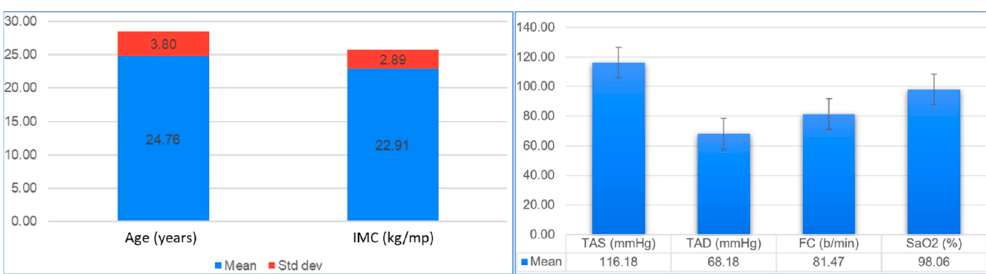
Figure 12. Biological parameters of the selected volunteers.